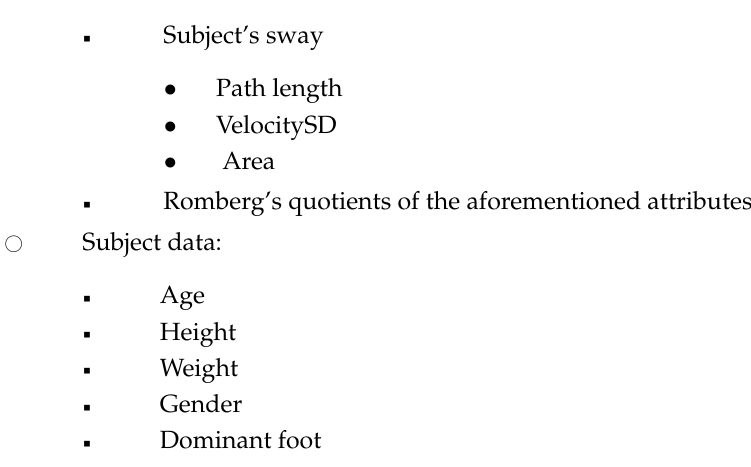
Figure 4. Screenshot of the software for the game